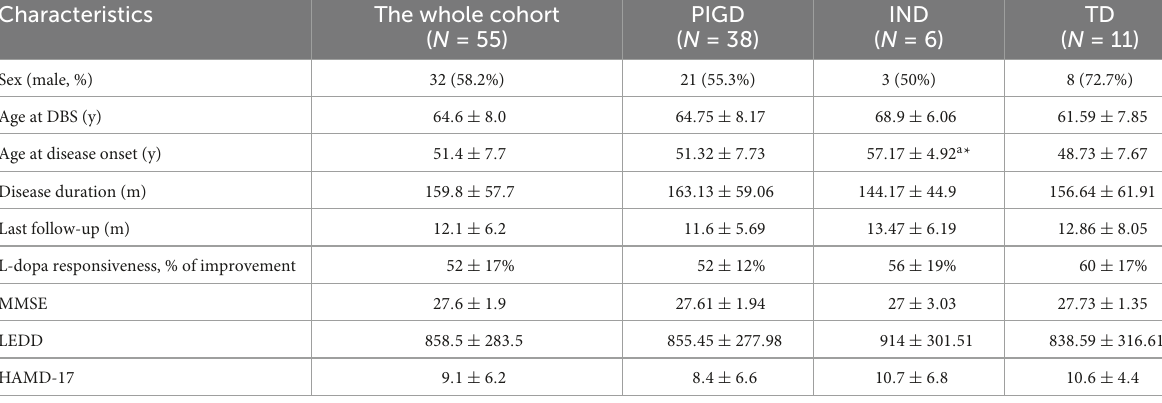
TABLE 1 Baseline characteristics of the whole cohort and different motor subtypes.